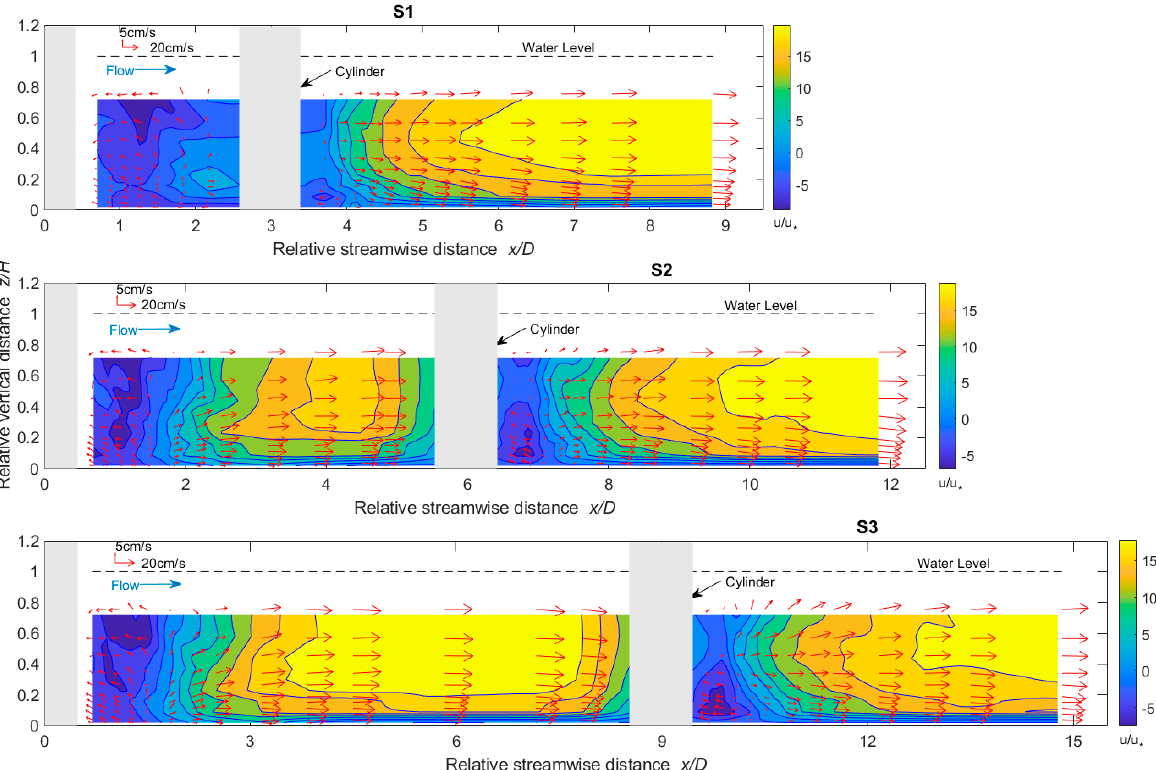
Figure 3. Velocity vector and isocontours of dimensionless streamwise velocity ( u/u * ) on the symmetry plane for the 3 experimental scenarios S1, S2, and S3, combining both midstream and downstream.